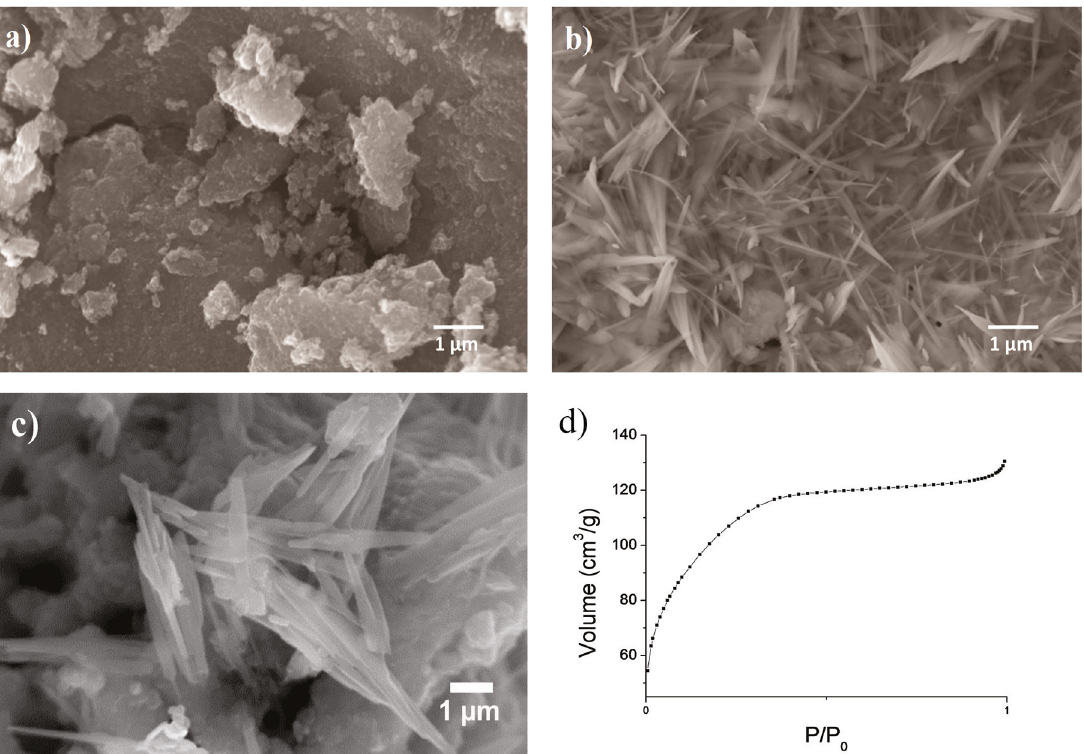
Figure 6: SEM images for the samples a) HMB150-30-0.1, b) HMB150-30-10, c) HMB150-30-1 and d) HMB150-30-10 BET adsorption